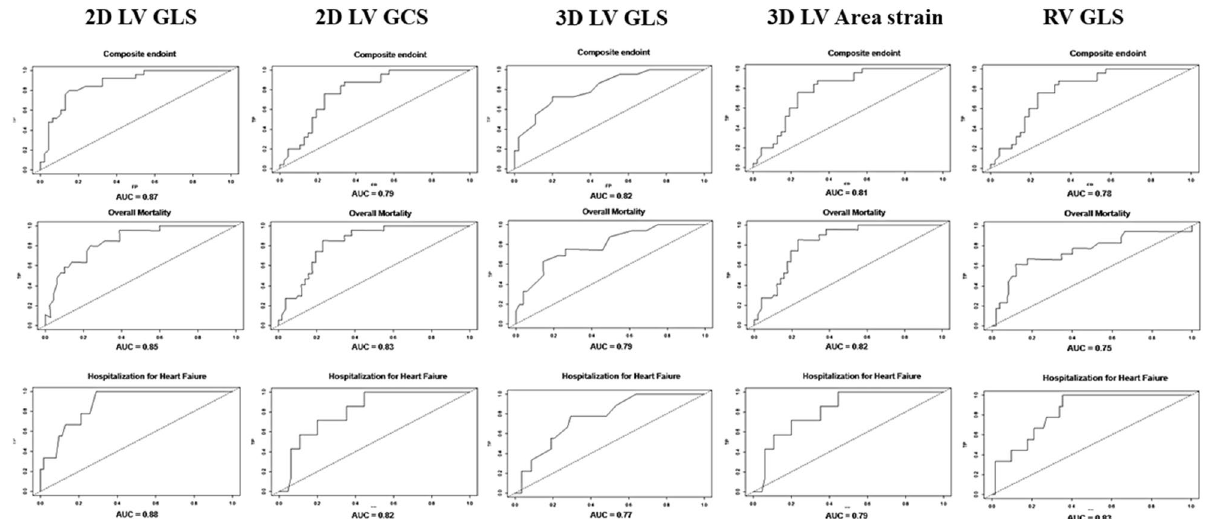
Figure 3. Receiver-operator characteristic (ROC) curves of the strong predictors of cardiovascular events during the 5 years of follow up. 2D LV GLS Two-dimensional left ventricular global longitudinal strain, 2D LV GCS Two-dimensional left ventricular global circumferential strain, 3D LV GLS Three-dimensional left ventricular global longitudinal strain, 3D LV Area strain Three-dimensionalleft ventricular area strain, AUC area under curve, RV GLS Right ventricular global longitudinal strain.